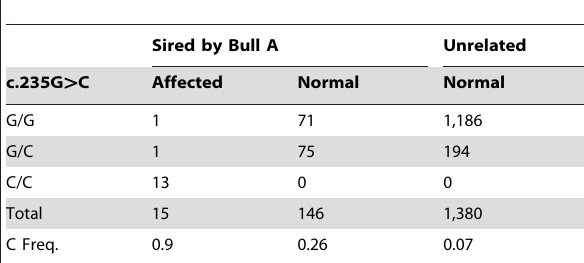
Table 3. Further genotyping of IARS